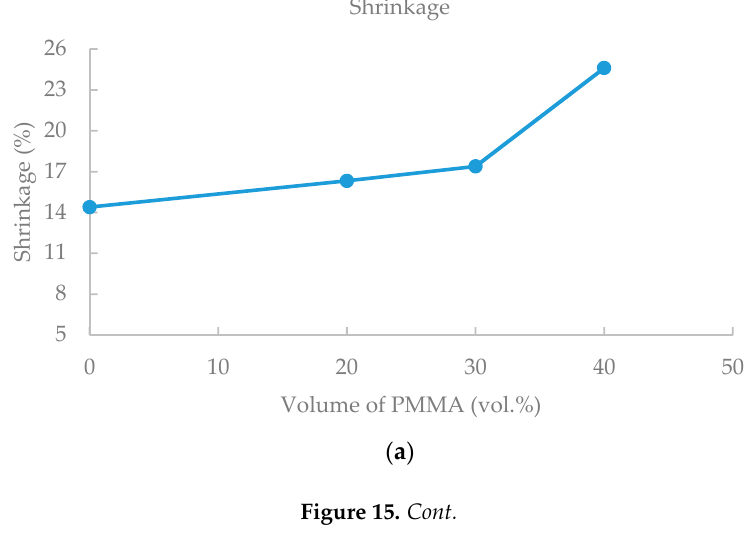
Figure 14. Sintered part and green part for different polymethyl methacrylate (PMMA) volumes.